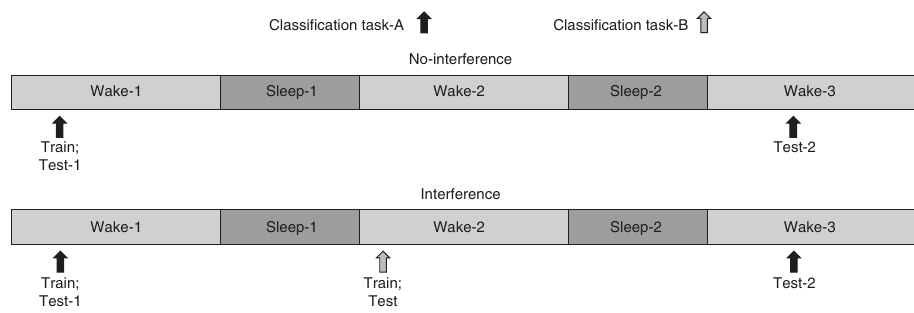
Fig. 6 Experimental design for experiment-3. Fifty-seven starlings were trained to classify 5 s segments of novel starling song. Starlings were trained on classi fi cation task-A from 9:30 a.m. to 12:00 p.m. and tested two times thereafter: immediately after training at 12:00 p.m. on day-1 and 48 h later at 12:00 p.m. on day-3. In the interference condition, starlings also were trained and tested on classi fi cation task-B on day-2 from 9:30 a.m. to 1:00 p.m. Task-B entailed the same Go/No-Go operant training and testing procedure as task-A but utilized a different pair of novel song stimuli than task-A. Each